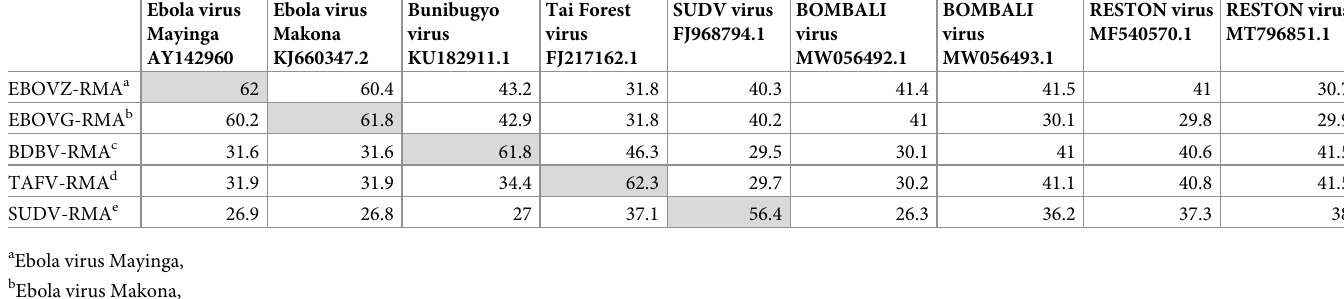
Table 4. Percent sequence identity of Ebolavirus-RMA sequence outputs with GenBank NCBI database sequences for Ebolaviruses. Header row contains the name and accession number of each database file. The first column contains the name of each resequencing microarray output which is a consensus of three